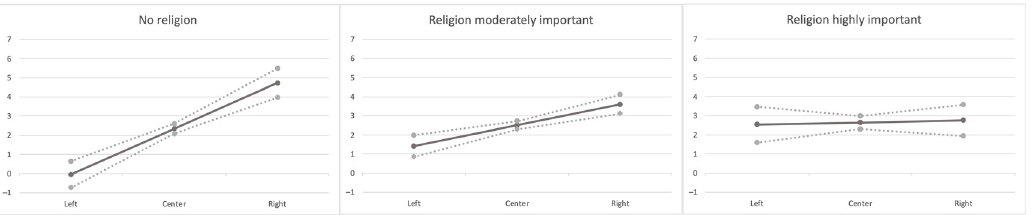
Figure 1. Predicted anger towards Muslims (estimate and confidence interval from Model 2) according to religiosity and political viewpoint: no religion to high importance. Note: predictions are for the latent underlying anger variable, and therefore allow for predictions outside the bounds of 1 to 7.